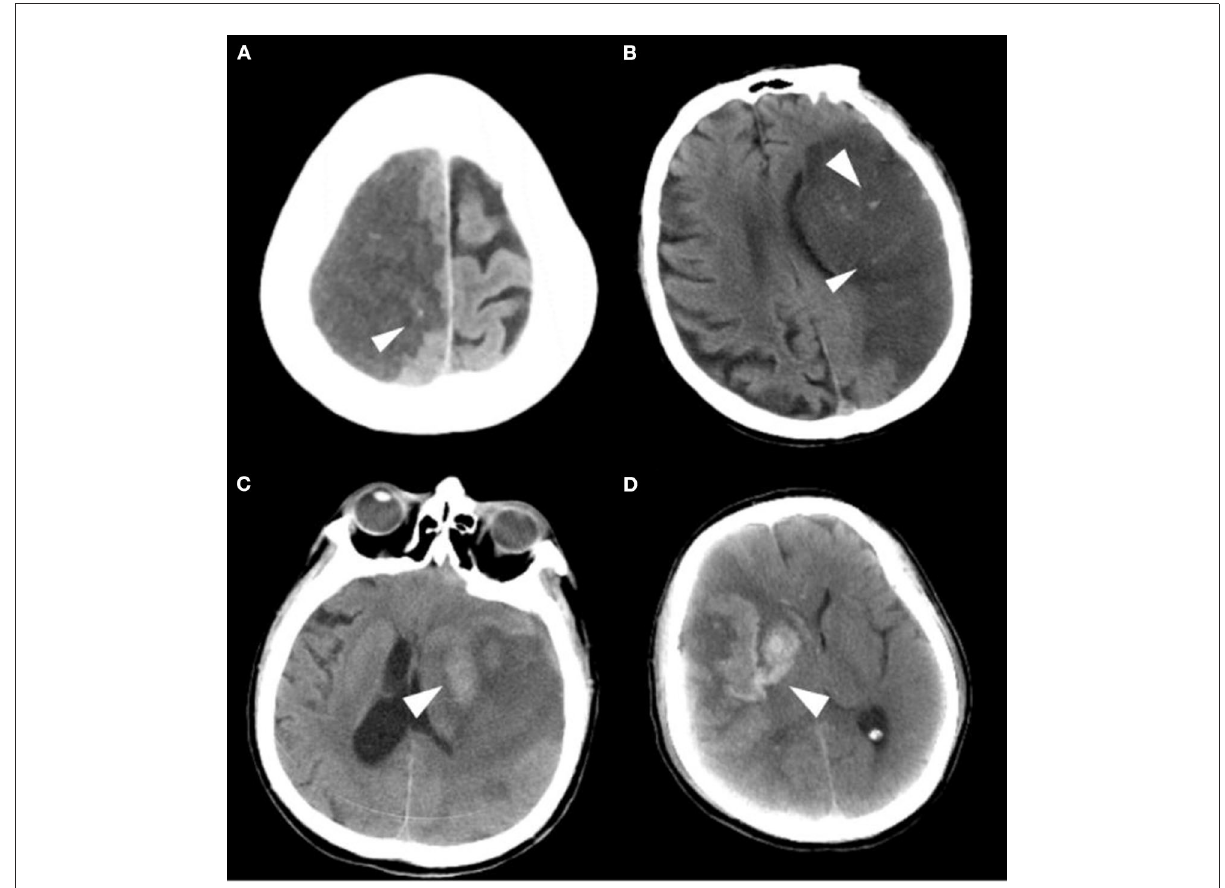
FIGURE2 Imaging classification of the hemorrhagic transformation. (A) HI 1: Small petechiae along the margins of the infarct. (B) HI 2: More confluent petechiae within the infarcted area, but without space-occupying effect. (C) PH 1: Blood clot not exceeding 30% of the infarcted area with some mild space-occupying effect. (D) PH 2: Dense blood clot(s) exceeding 30% of the infarct volume with significant space-occupying